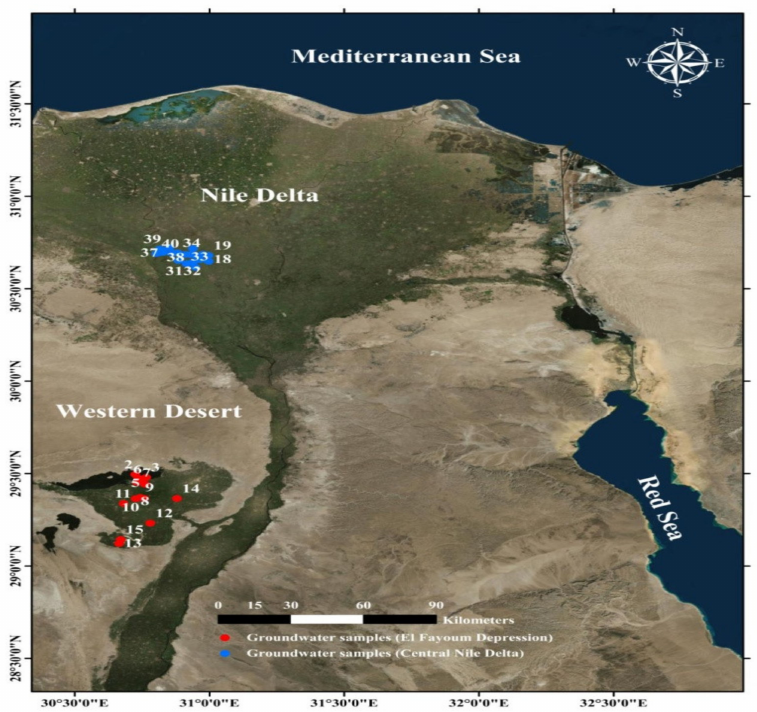
Figure 1. Location of the El Fayoum depression in the Western Desert (red points) and the Central Nile Delta (green points) and their measuring